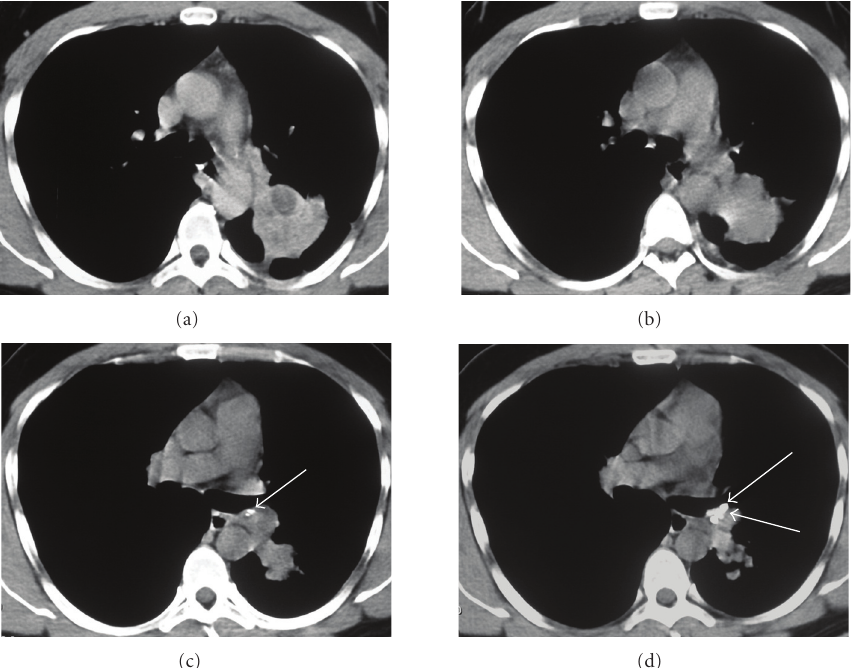
Figure 1: HRCT scans with mediastinal window (a)–(d) demonstrated a mass with irregular borders, measuring about 6cm in diameter, with pleural extension and thickening of adjacent pleura, located in the upper segment of the left lower lobe. The mass was heterogeneous with hypodense areas. Amorphous calcifications were also present in the mass (c, d) (arrows).